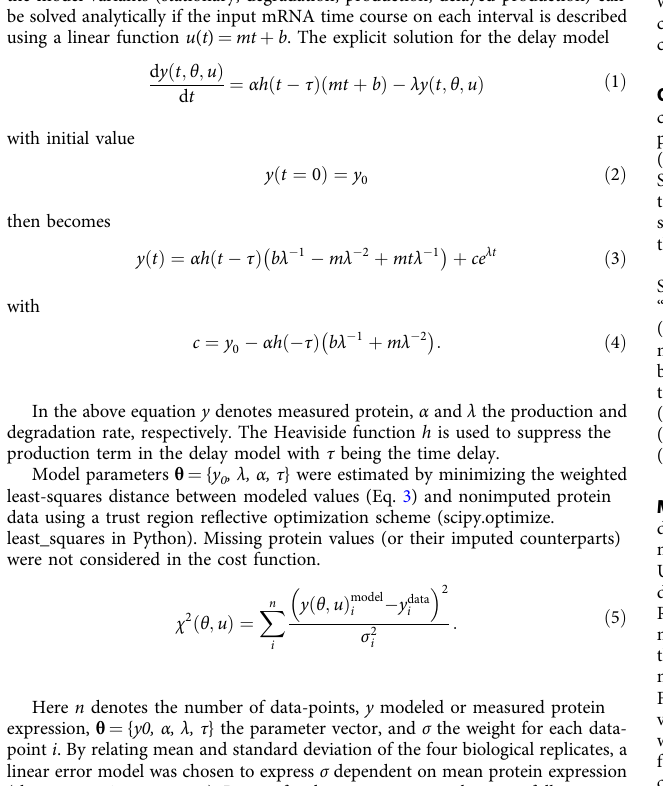
matching mRNA at time t n with protein at time t n + i with i 2 Z : (cid:2) 5 (cid:3) i (cid:3) 5. Unmatched time points were left out, leading to a minimum number of six paired values for the assessment of correlation. mRNA/protein correlations with a p value <0.05 ( p value returned by scipy.stats.spearmanr — Student ’ s t test, two-sided) were chosen as signi fi cant.